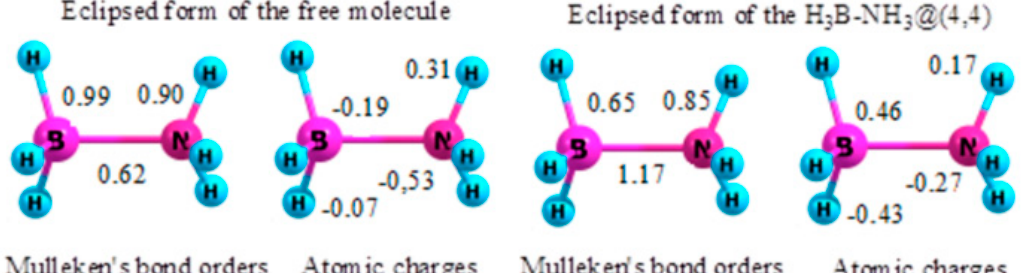
Figure 6. Parameters of free and encapsulated ammonia borane. Adapted with modification [151].